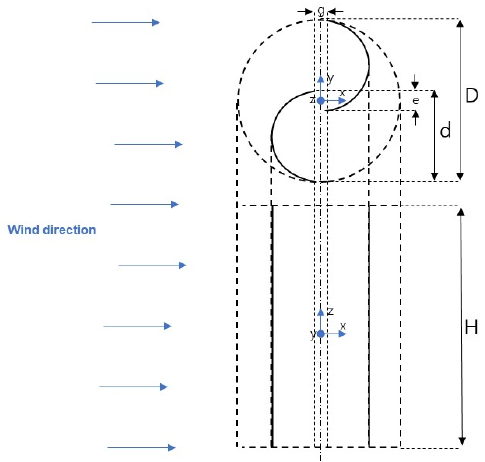
Figure 4. Savonius wind turbine geometry and design parameter definitions.